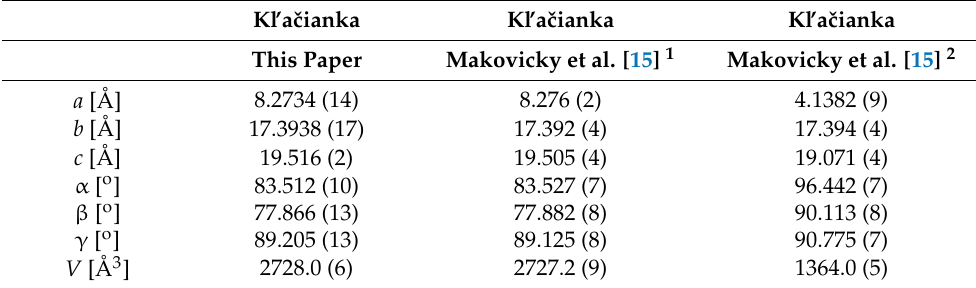
Table 2. Unit-cell parameters of dadsonite (for triclinic space group P -1).